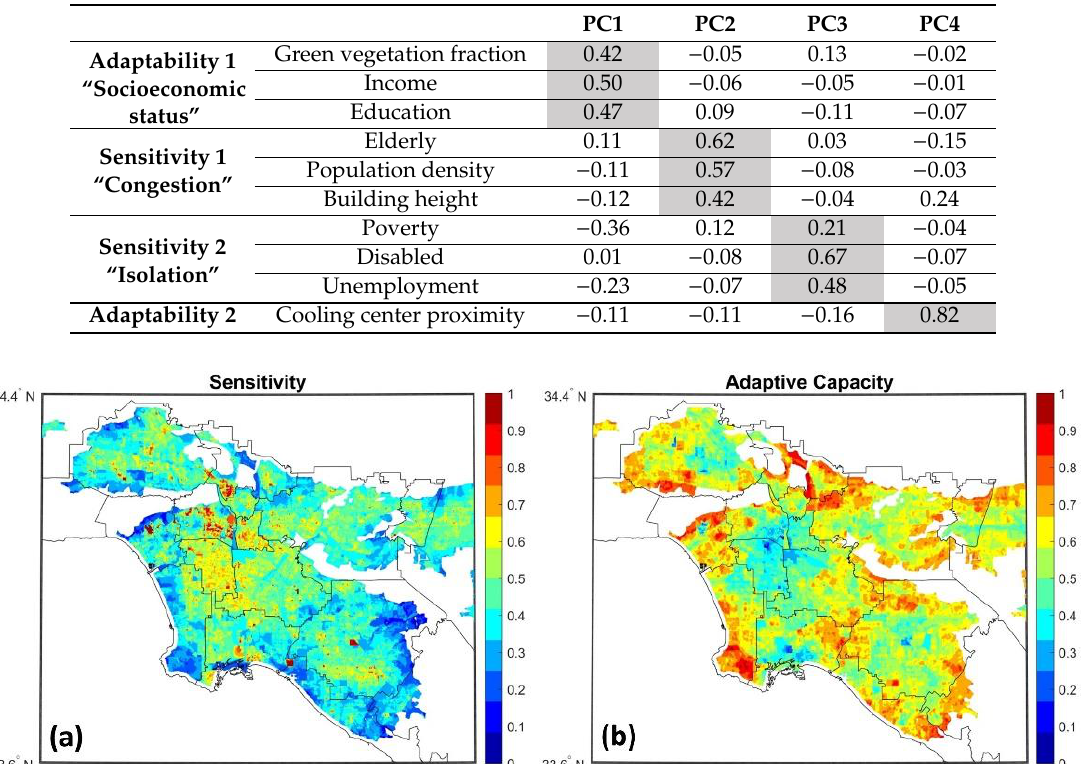
Table 1. Principal component (PC) coefficients (loadings) after varimax rotation for four principal components.